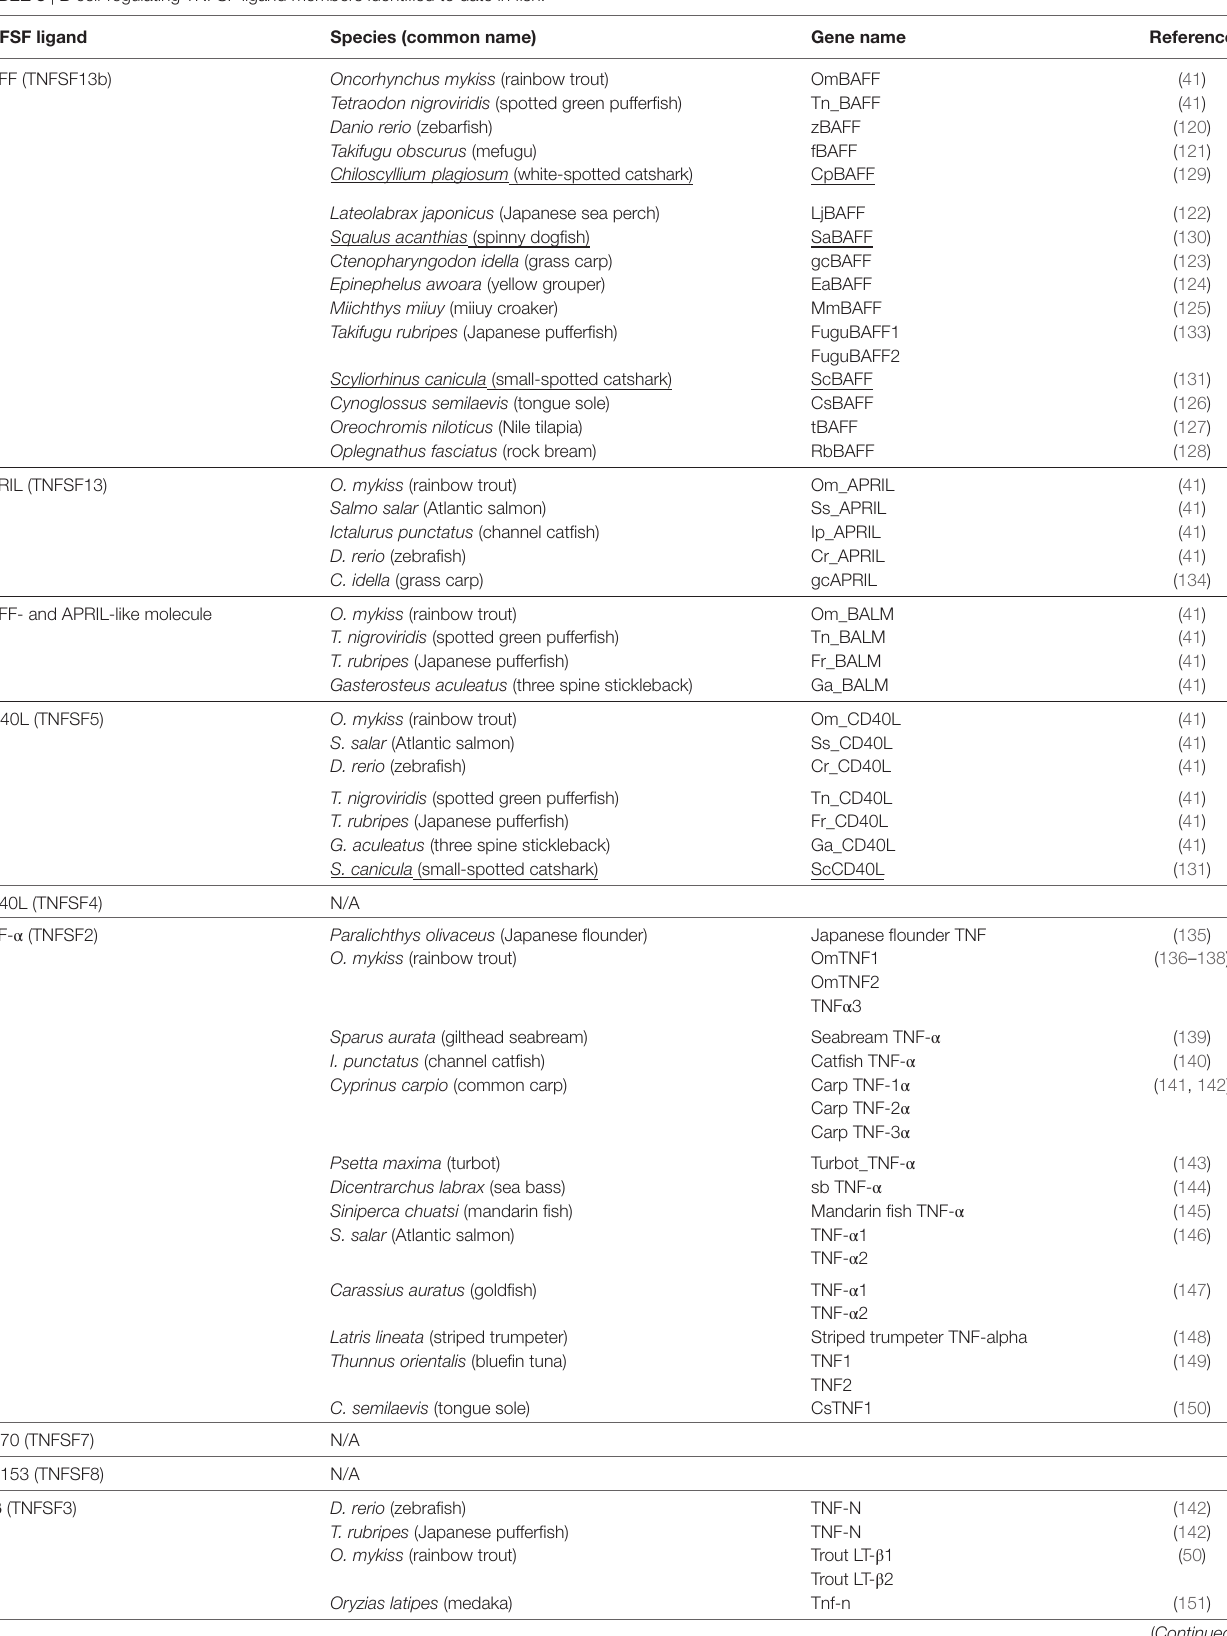
TaBle 3 | B cell-regulating TNFSF ligand members identified to date in